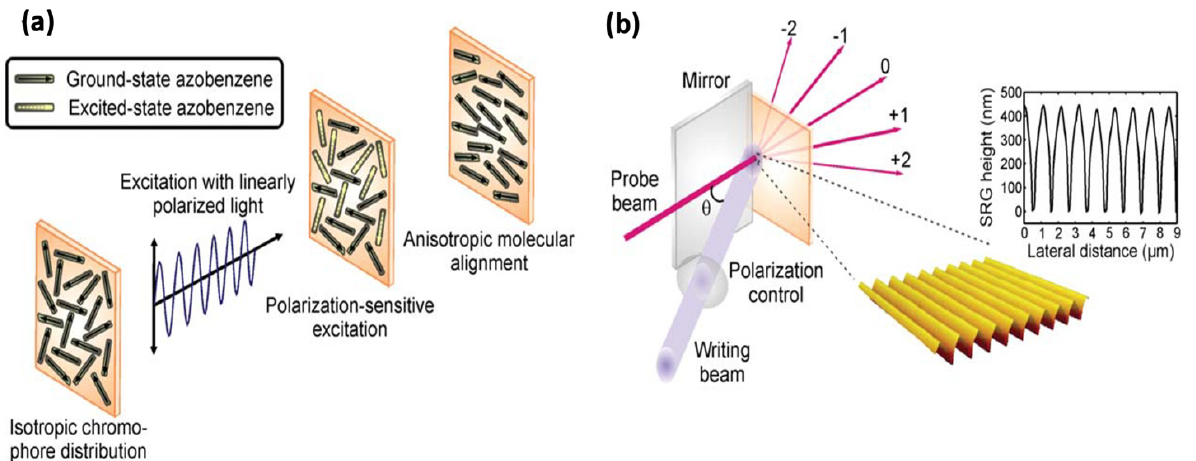
Figure 5. ( a ) Schematic illustration of the photoalignment of azobenzenes with polarized light. ( b ) Schematic representation of the SRG inscription process. An atomic-force micrograph and a surface profile of an inscribed grating are shown on the right. (Reprinted with permission from [76] Copyright @ 2013, John Wiley and Sons).